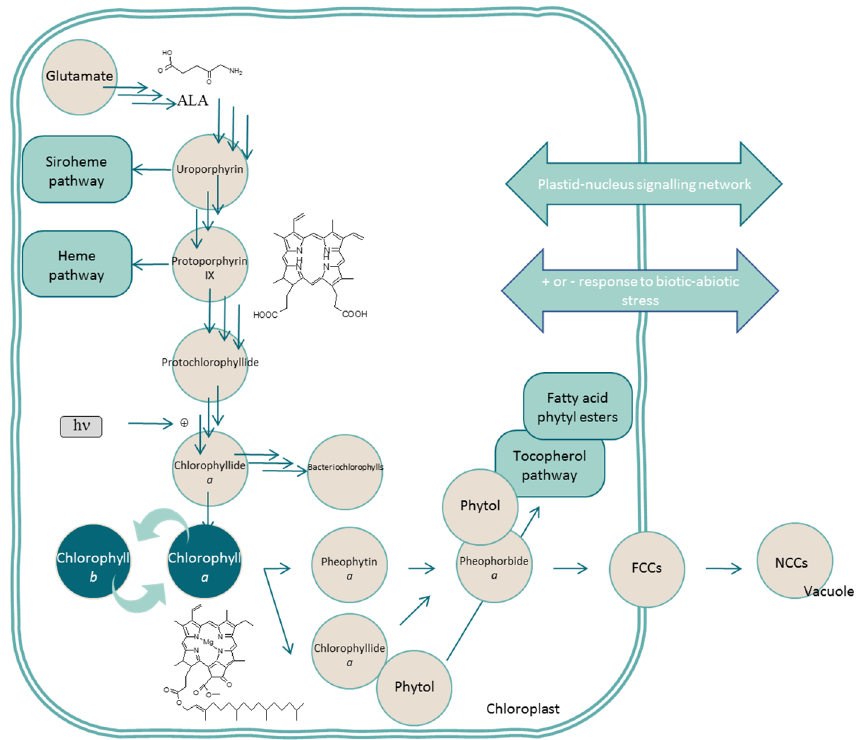
Figure 3. Brief description of the biosynthesis and catabolism of chlorophylls and routes related to other